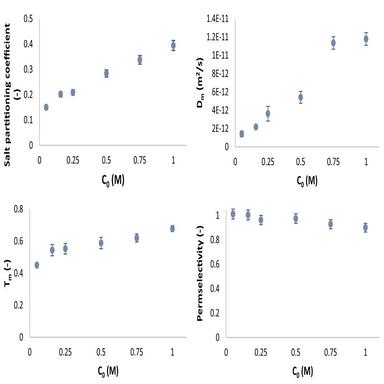
Properties determined for Type 10 Fujifilm CEM.